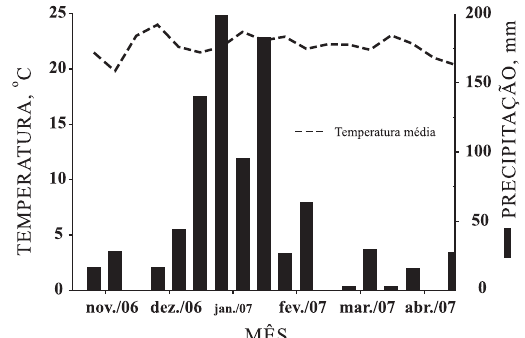
Figura 1. Precipitação (mm) e temperatura média em decêndio (°C), observadas durante a condução do experimento em